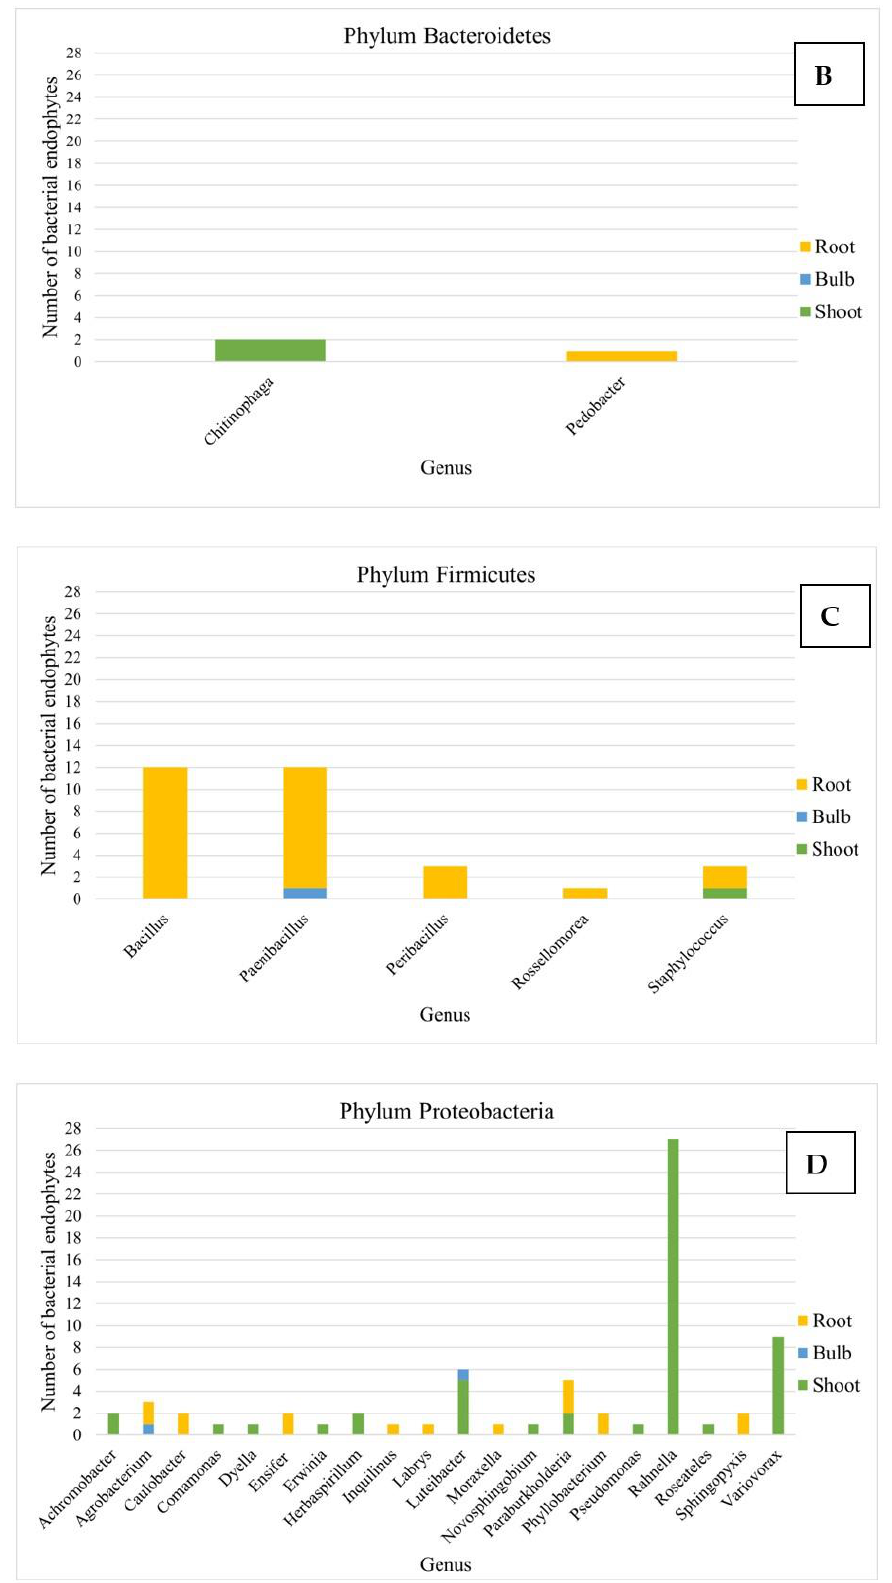
Figure 2. Taxonomical composition of the bacterial collection isolated from L. aestivum ‘Gravety giant’. ( A ) Phylum Actinobacteria, ( B ) Phylum Bacteroidetes, ( C ) Phylum Firmicutes, ( D ) Phylum Proteobacteria.